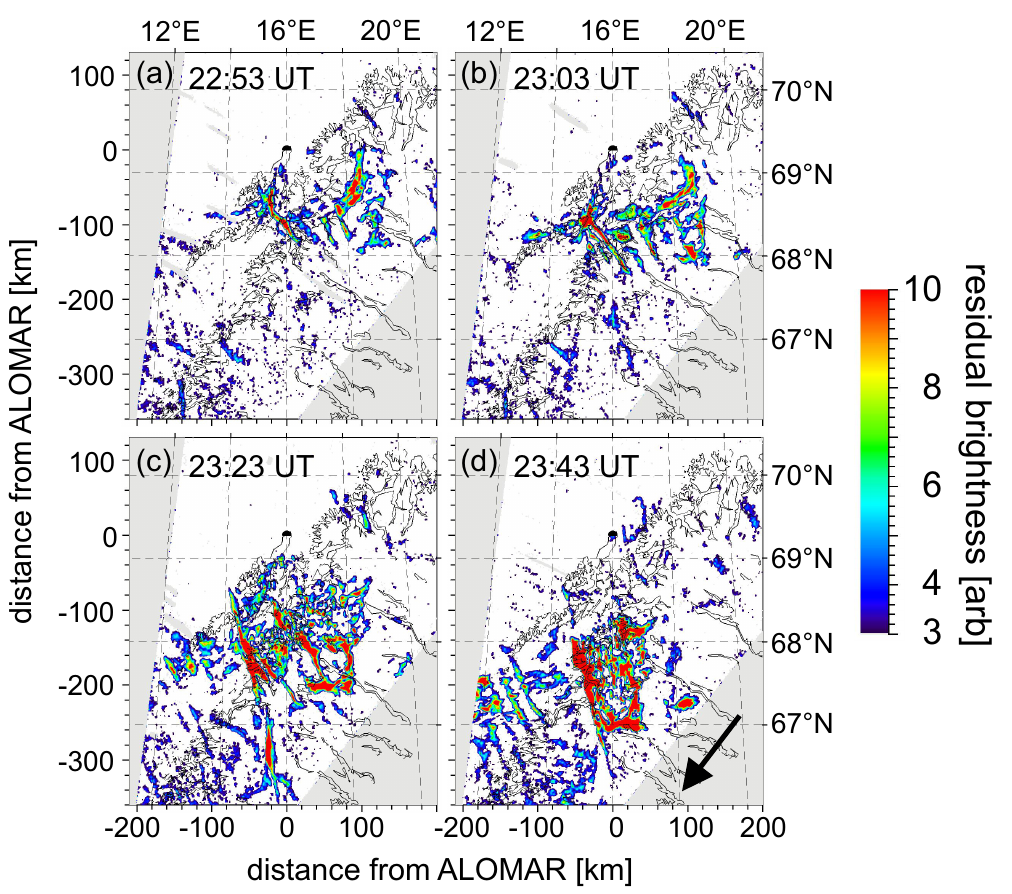
Fig. 14. Temporal evolution of the noctilucent cloud (a) 22:53UT; (b) 23:03UT; (c) 23:23UT; (d) 23:43UT. The same color scale as in Fig. 11 is used. The wind direction as measured by the SKiYMET radar at ALOMAR is indicated by an arrow.